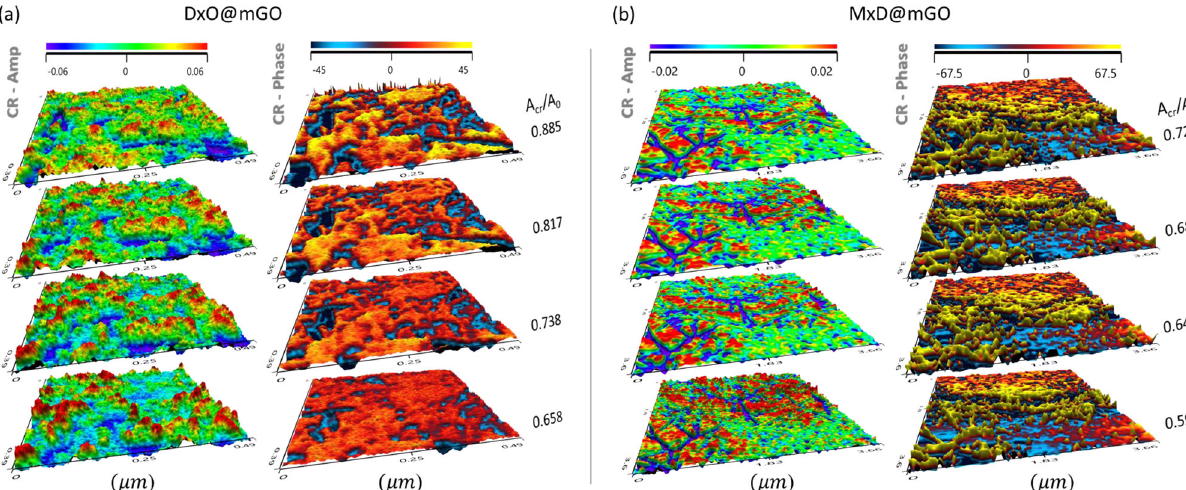
Fig. 7 Contact resonance-enhanced dynamic contrasts of infrared (IR) amplitude and phase contrast. Contact resonance-enhanced amplitude contrast (left — CR-Amp) and contact resonance-enhanced phase contrast (right – CR-Phase) variations with setpoint @ 1416 cm − 1 on a DxO@mGO and b @ 1455 cm − 1 on MxD@mGO. The x -axis and y -axis scales of a DxO@mGO is 0.49 µ m × 0.39 µ m and that of b MxD@mGO is 3.66 µ m × 3.6 µ m. The long- timescale conduction dissipation path is measured from the cantilever de fl ection as IR amplitude contrast while the transitional dissipation path is measured from resonance fl uctuations from the phase signal locked in at the contact resonance IR pulsing frequency. As clear from the results DxO has